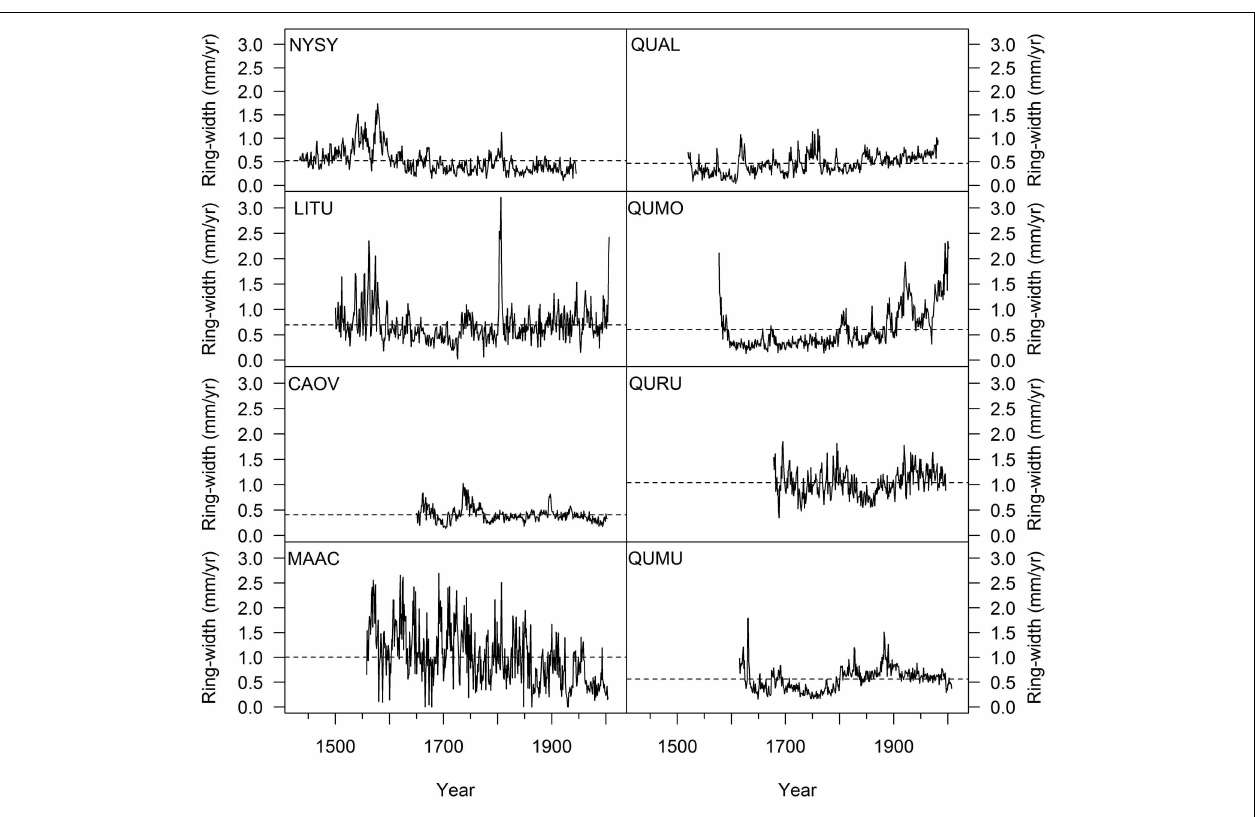
Liriodendron tulipifera ; CAOV, Carya ovata ; MAAC, Magnolia acuminata ; QUAL, Quercus alba ; QUMO, Quercus montana ; QURU, Quercus rubra ; QUMU, Quercus muehelebergii